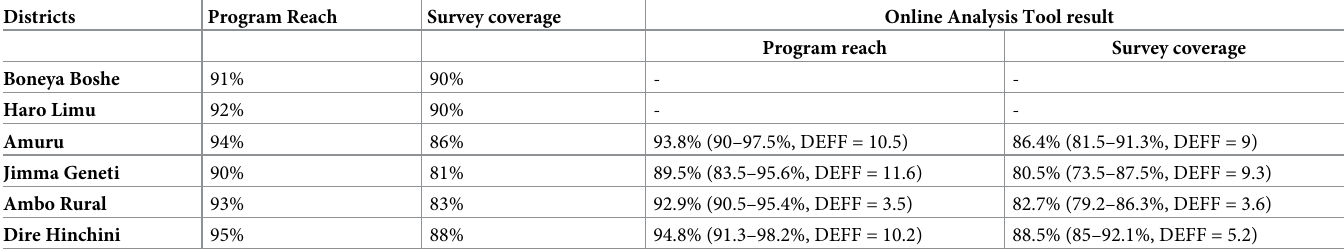
Table 7. Proportion of Program Reach and Survey Coverage of MDA Distribution among six districts of East Wollega, Horo Guduru Wollega and West Shewa Zones, Oromia, 2017. Districts